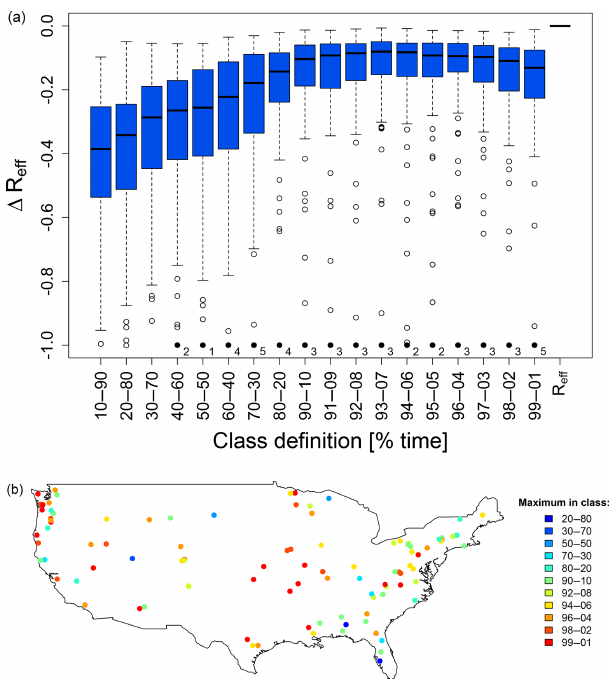
Figure 5. Difference in median model validation results relative to the upper benchmark ( (cid:49)R eff ) for models calibrated with two water level classes for different class boundary definitions (a) and a map of the optimal class boundary definition for each catchment (b) . As an example, 20–80 indicates that streamflow was in the lower stream level class for 20% of the time and in the upper class for 80% of the time. The median difference in model efficiency and the upper benchmark is smallest when the class boundary is set at 93–7%.